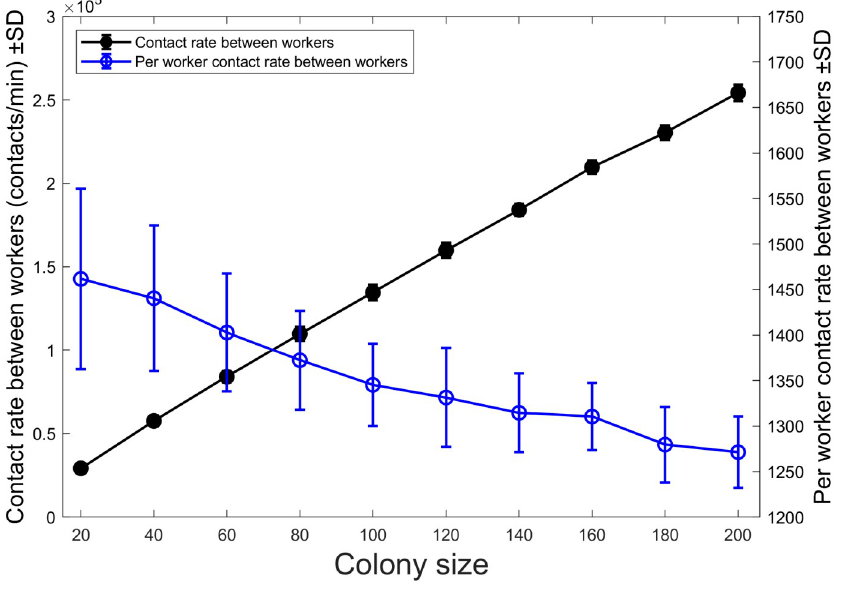
Fig 8. Contact rate between workers. The contact rate between workers (black line) increases with colony size. An increased colony means more workers so there will be more contacts in general. When looking at the per-worker contact rate (blue line), there is a decrease with colony size similar to that seen in Fig 7A. There appears to be a decrease in the contact efficiency not just between the queen and workers but also between workers.